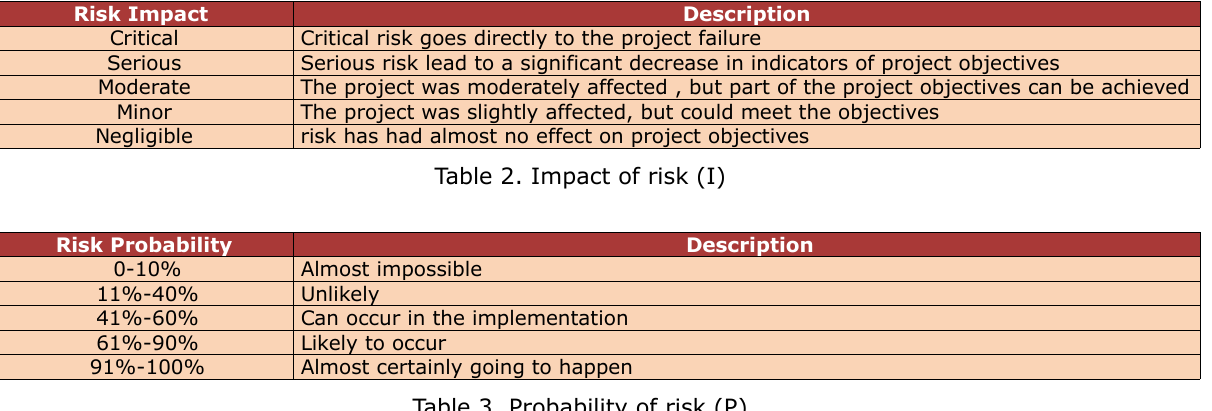
Table 3. Probability of risk (P)